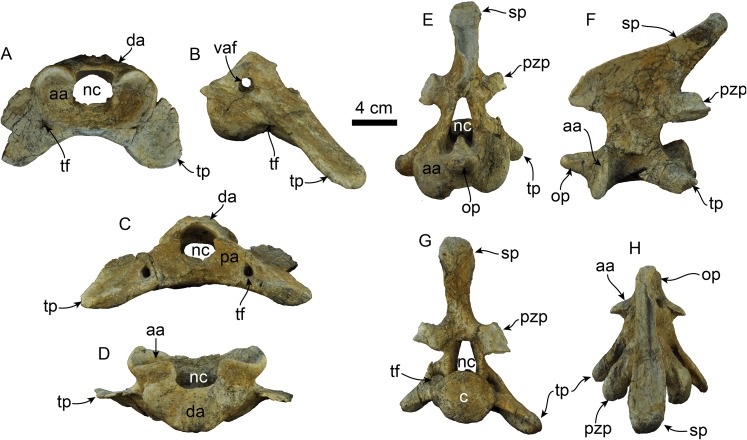
Atlas and axis of Titanotaria orangensis n. gen. et sp. (OCPC 11141).Atlas in anterior (A), left lateral (B), posterior (C), and dorsal (D) views; axis in anterior (E), left lateral (F), posterior (G), and dorsal (H) views. Abbreviations: aa, anterior articular surface; c, centrum; da, dorsal arch; nc, neural canal; op, odontoid process; pa, posterior articular surface; pzp, postzygapophysis; sp, spinous process; tf, transverse foramen; tp, transverse process; vaf, vertebrarterial foramen.